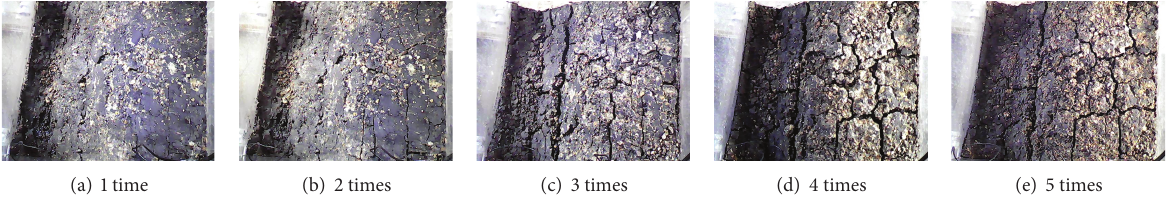
Figure 5: The expansive soil cracks of different dry-wet cycles